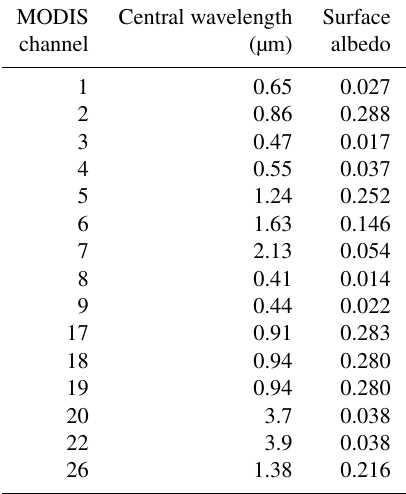
Table 1. Constant surface albedo setting used in smoke AOD re- trieval investigation